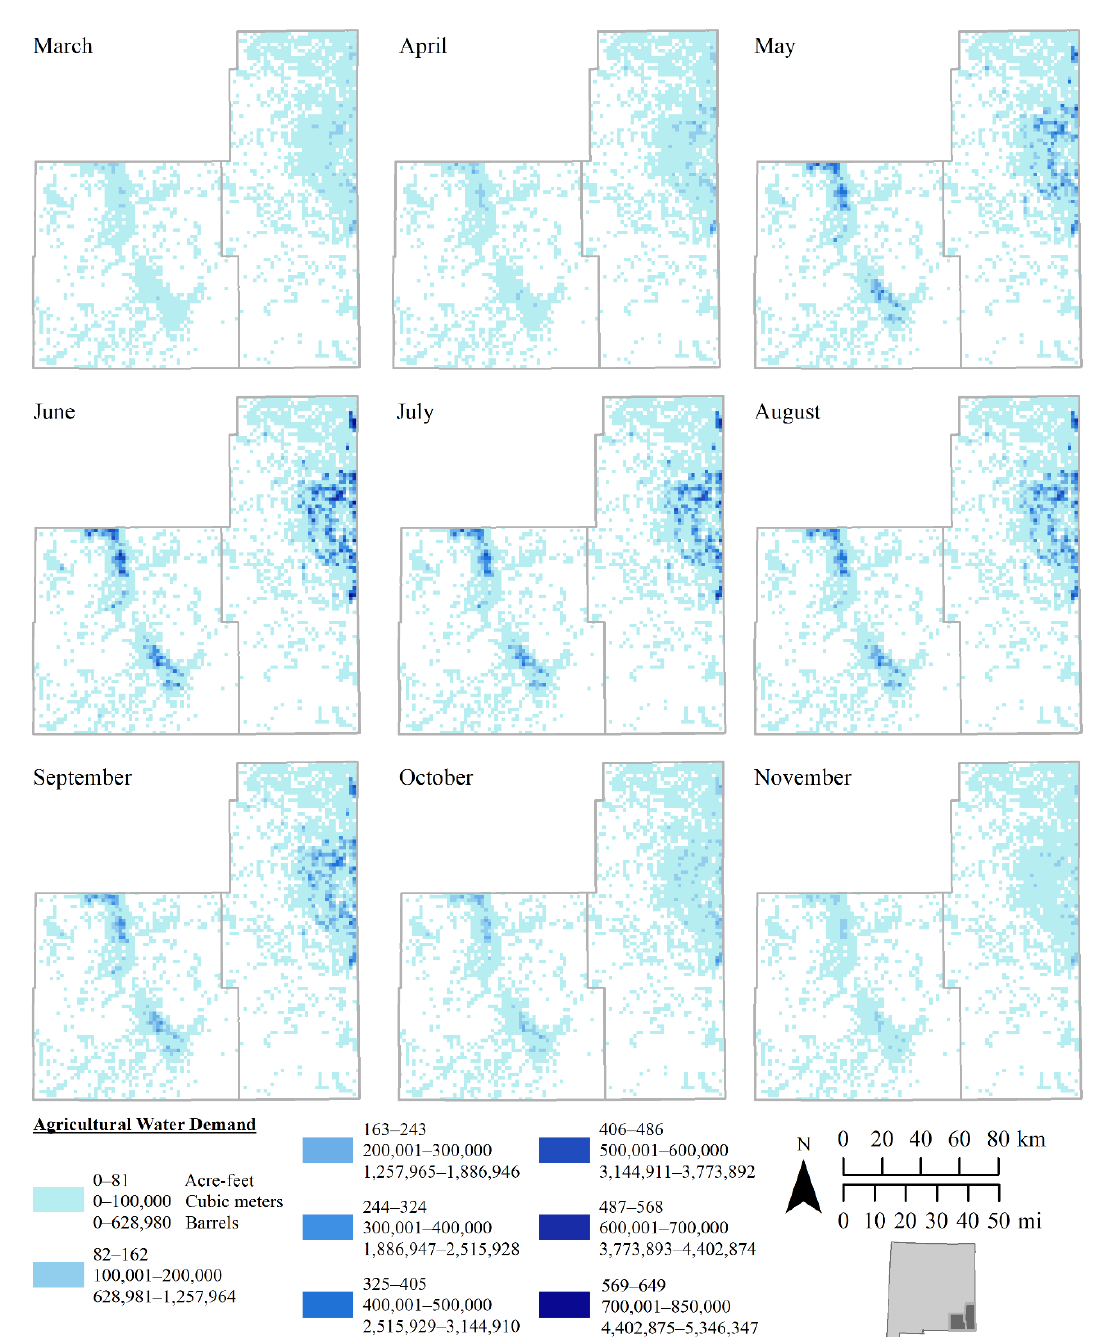
Figure 7. Spatiotemporal analysis of irrigated crop water demand for Eddy and Lea counties based on 2020 data.